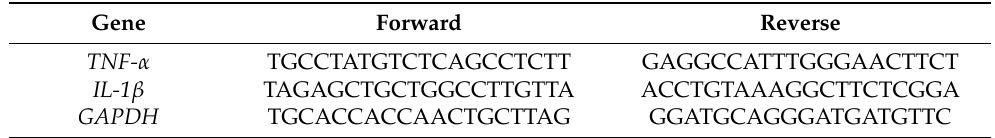
Table 1. Primer sequences of mice TNF- α , IL-1 β , and GAPDH for RT-PCR. Gene Forward Reverse TNF- α TGCCTATGTCTCAGCCTCTT GAGGCCATTTGGGAACTTCT IL-1 β TAGAGCTGCTGGCCTTGTTA ACCTGTAAAGGCTTCTCGGA GAPDH